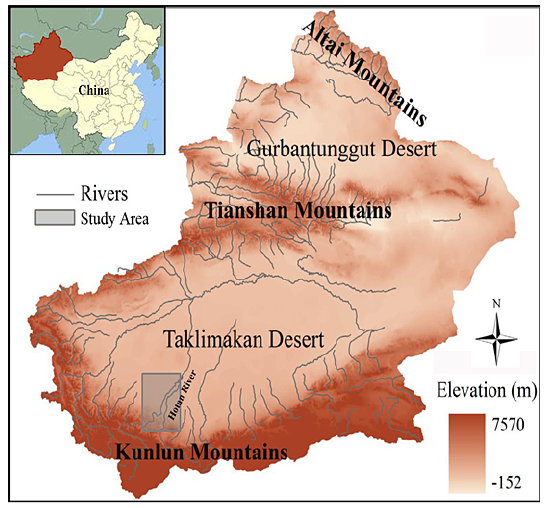
Figure 1. Sketch map of the study